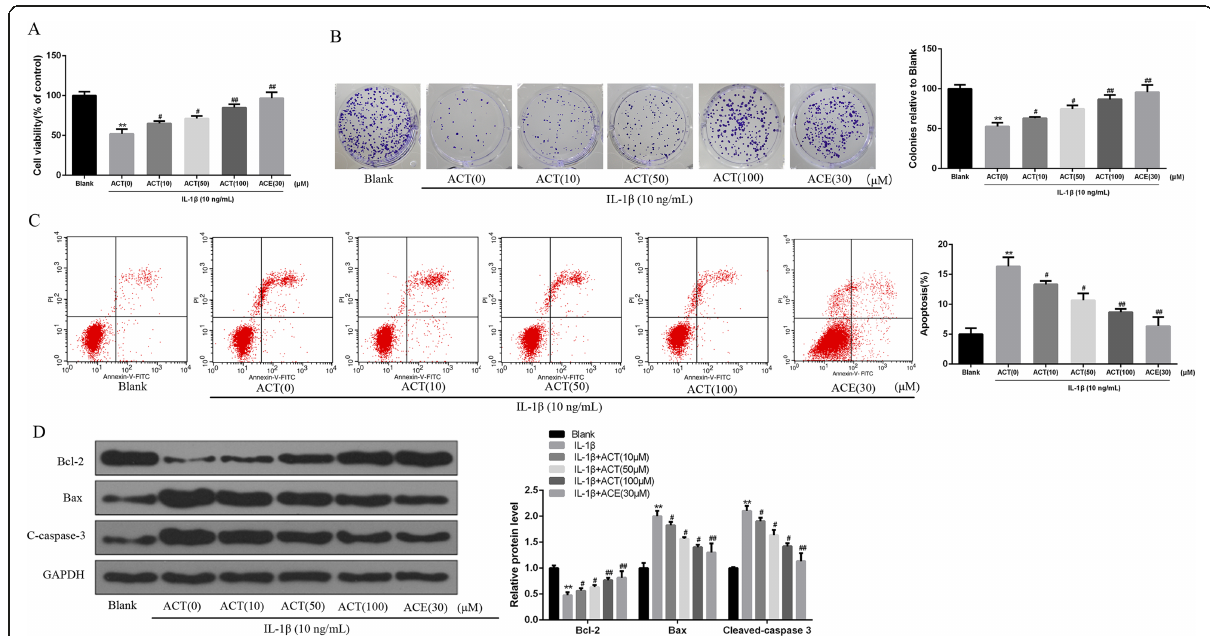
Fig. 3 ACT promotes cell proliferation and inhibits cell apoptosis in primary chondrocyte stimulated by IL-1 β . Rat primary chondrocytes were untreated or treated with 10 ng/mL IL-1 β together with different concentration of ACT ACE (positive control, 30 μ M) for 24 h. a MTT assay was performed to examine chondrocyte viability. b chondrocyte proliferation was measured by colony formation assay. c Annexin V/PI staining was performed to examine the chondrocyte apoptosis. d The protein expression of Bcl-2, Bax, and Cleaved-caspase 3 were analyzed. *** p < 0.001, **